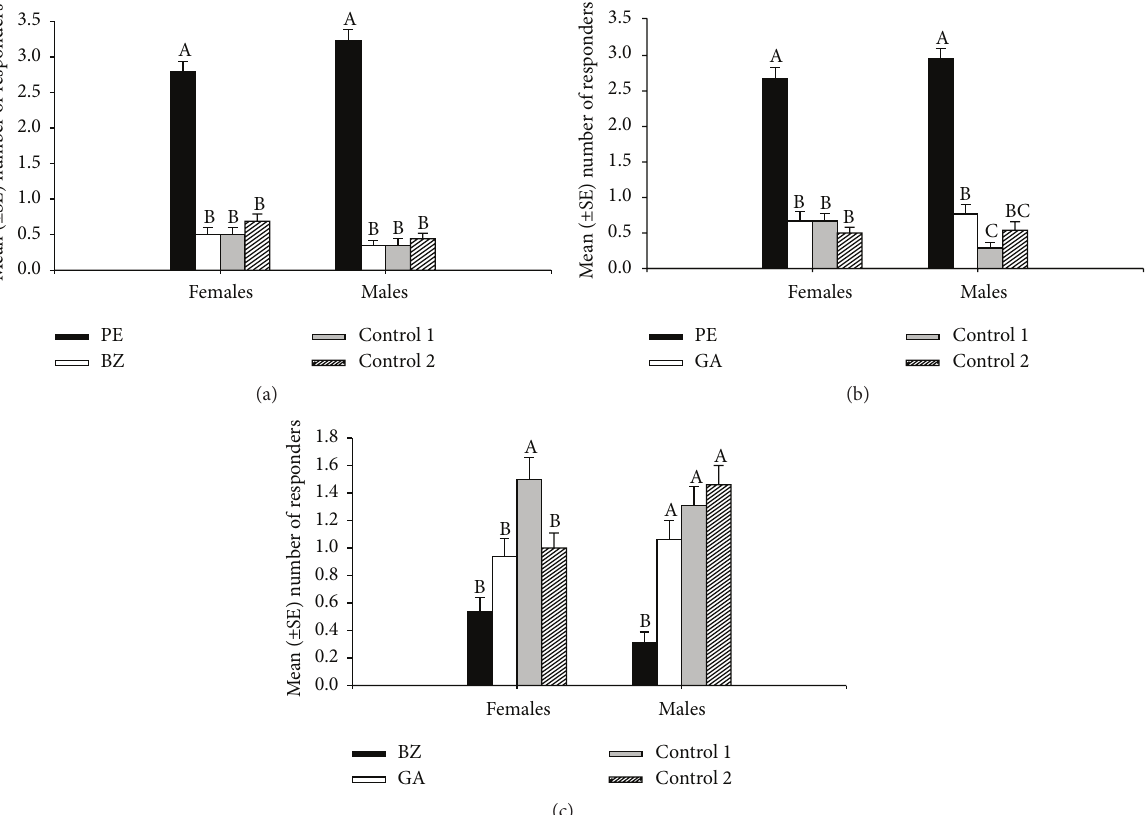
Figure 1: Response of plum curculio to commercial lures of benzaldehyde (BZ), plum essence (PE), and grandisoic acid (GA) in four-choice olfactometer bioassays. In each test, two lure treatments (binary test) and two controls were compared: (a) BZ versus PE; (b) PE versus GA; and (c) BZ versus GA. In this figure and Figure 2, Control 1 = air and Control 2 = empty microcentrifuge vial. Groups of five weevils of either sex were released per test in the olfactometer and replicated six times. Means for each sex having no letter in common are significantly different (ANOVA, Tukey-Kramer HSD, 𝑃 < 0.05